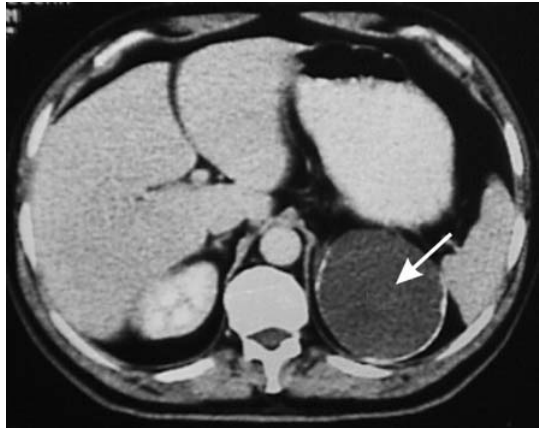
FIGURE 3. CT scan showing a left adrenal cystic lesion with tiny peripheral calcifications